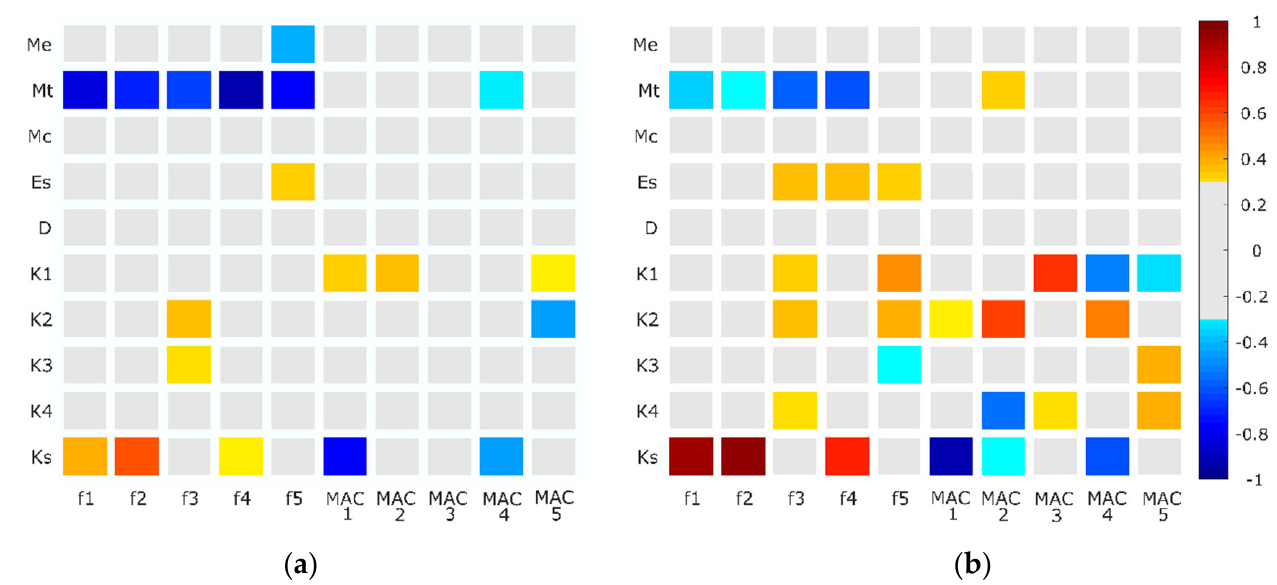
Figure 12. Spearman correlation matrix: ( a ) unloaded configuration, ( b ) loaded configuration.